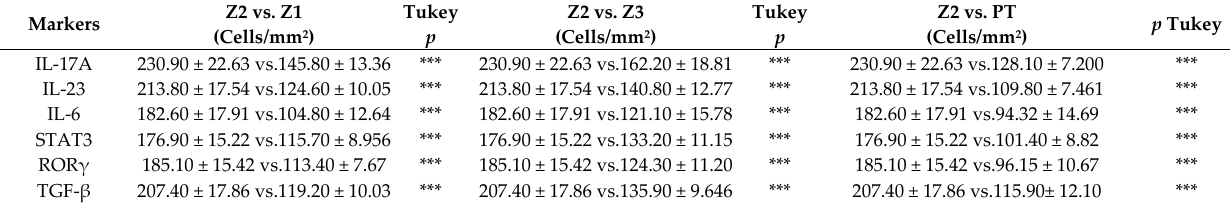
Table 4. Comparative analysis (mean + standard deviation) of the expression of Th17 markers in 21 YF patients between the different compartments